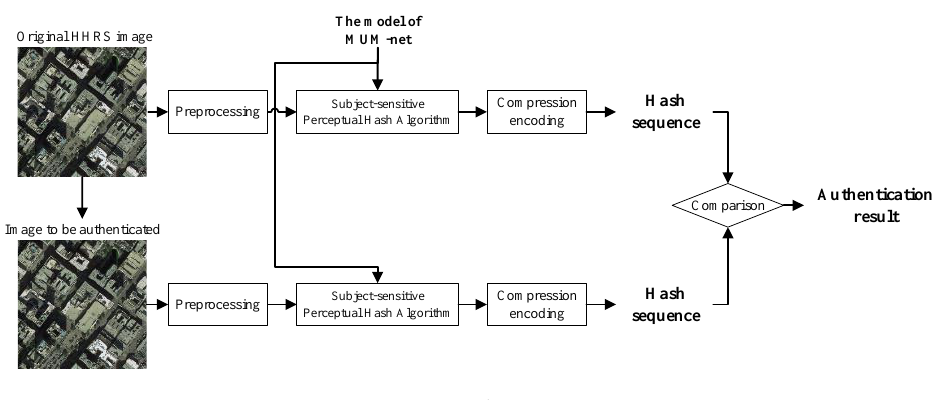
Figure 6. Integrity authentication process